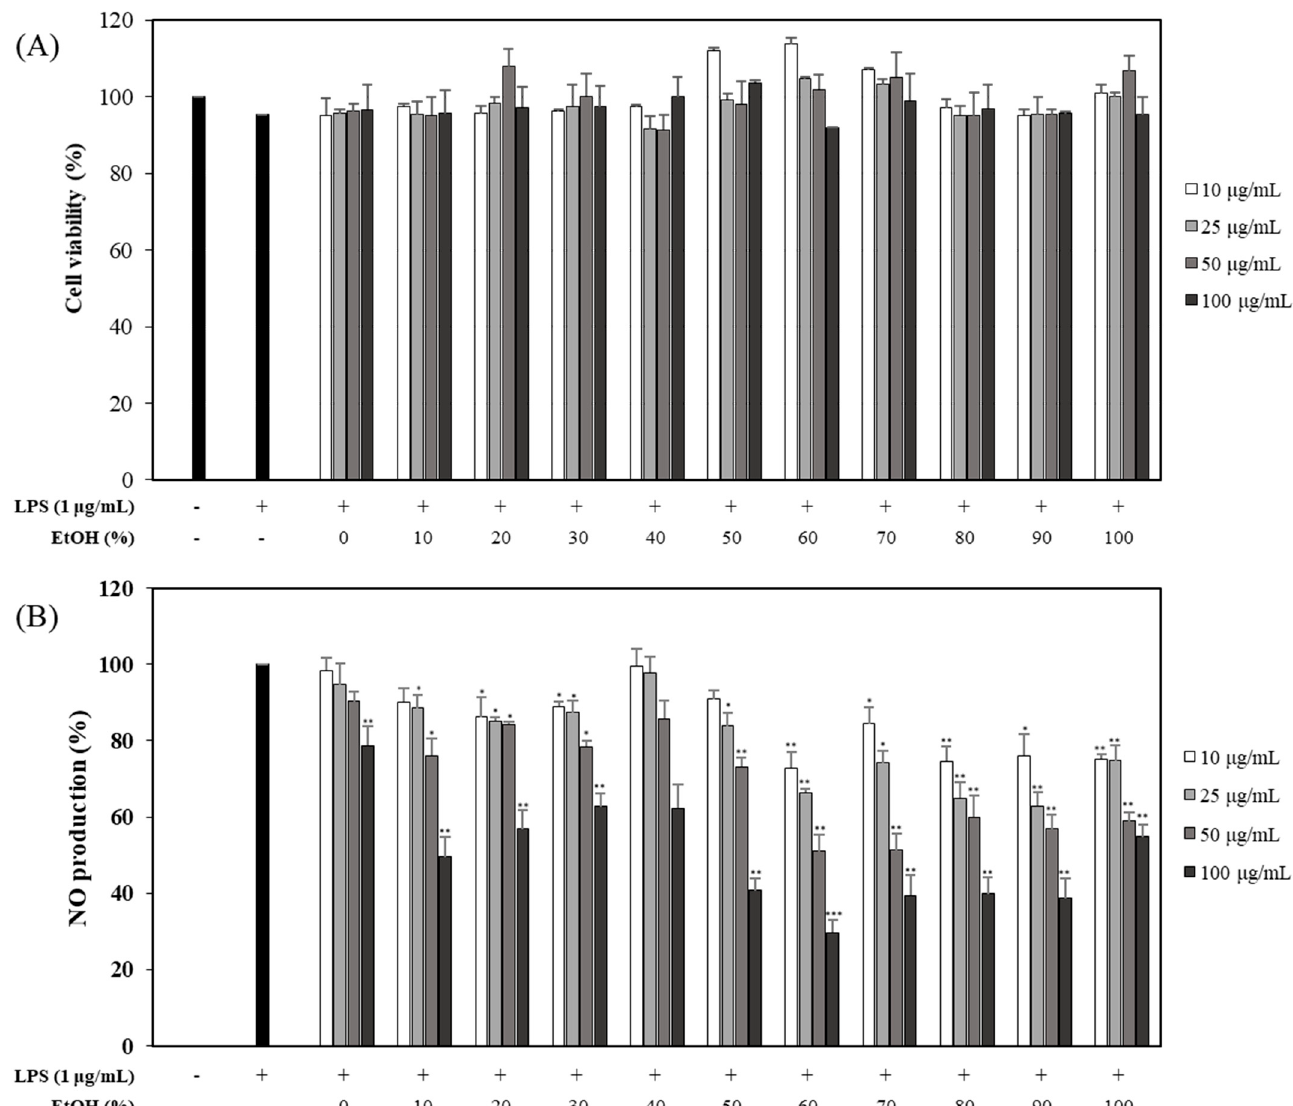
Figure 1. Effects of OFLEs obtained with various solvent ratios on cell viability and NO production. RAW 264.7 cells were cultured in the presence of eleven OFLEs (harvested in June) at various concentrations (10, 25, 50, and 100 µ g/mL) for 1 h and then induced with LPS (1 μ g/mL) for 20 h. Cell viability ( A ) and NO production ( B ) were measured using MTT assay and Griess reagent, respectively. Nitrite concentrations of non-treated and LPS-treated controls were 0.9 ± 0.1 μ M and 17.6 ± 0.2 μ M, respectively. Each experiment was performed in triplicates. Data are presented as mean ± SD. * p < 0.05, ** p < 0.01, *** p < 0.001 vs. LPS-treated group.